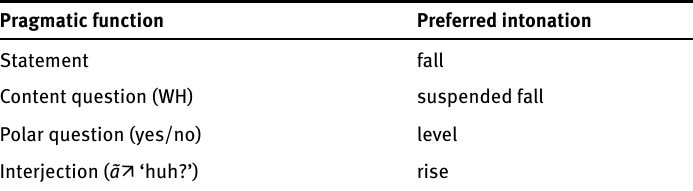
Table 4: Some pragmatic functions and preferred intonation contours in Siwu Pragmatic function Preferred